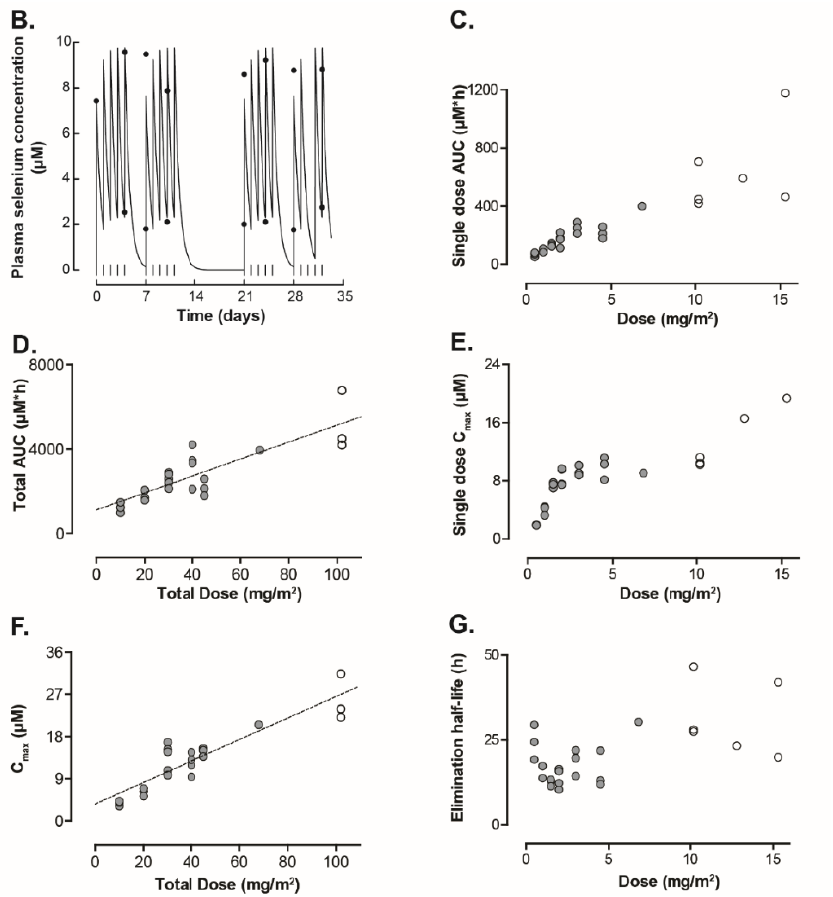
Figure 3. ( A ) Plasma selenium concentration in different cohorts receiving increasing concentration of sodium selenite during the first two-weeks of treatment. ( B ) Plasma selenium concentration–time curve in Patient 9. The daily dose (1.5 mg/m 2 ) was given as a 20 min constant rate infusion. Start of infusions is indicated by the vertical lines. Measured serum concentrations are given by the filled circles. ( C , D ) Systemic selenium exposure is expressed as area under the serum concentration–time curve (µM*h). Figure 3C shows data from a single dose of selenite and data from the entire treatment period are presented in Figure 3D. ( E , F ) Figure 3E represent maximum concentration of selenium after a single dose of selenite. Maximum concentration of selenium during the entire treatment period is presented in Figure 3F. ( G ) Elimination half-life of selenium at different doses. In all the figures, filled circles indicate data from 20 min infusions and open circles data from 40 min